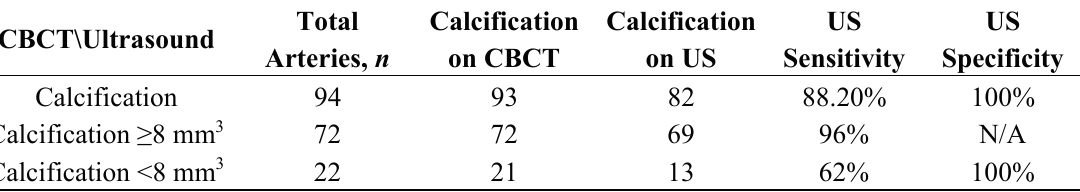
Table 3. Accuracy of Doppler ultrasound in detecting carotid